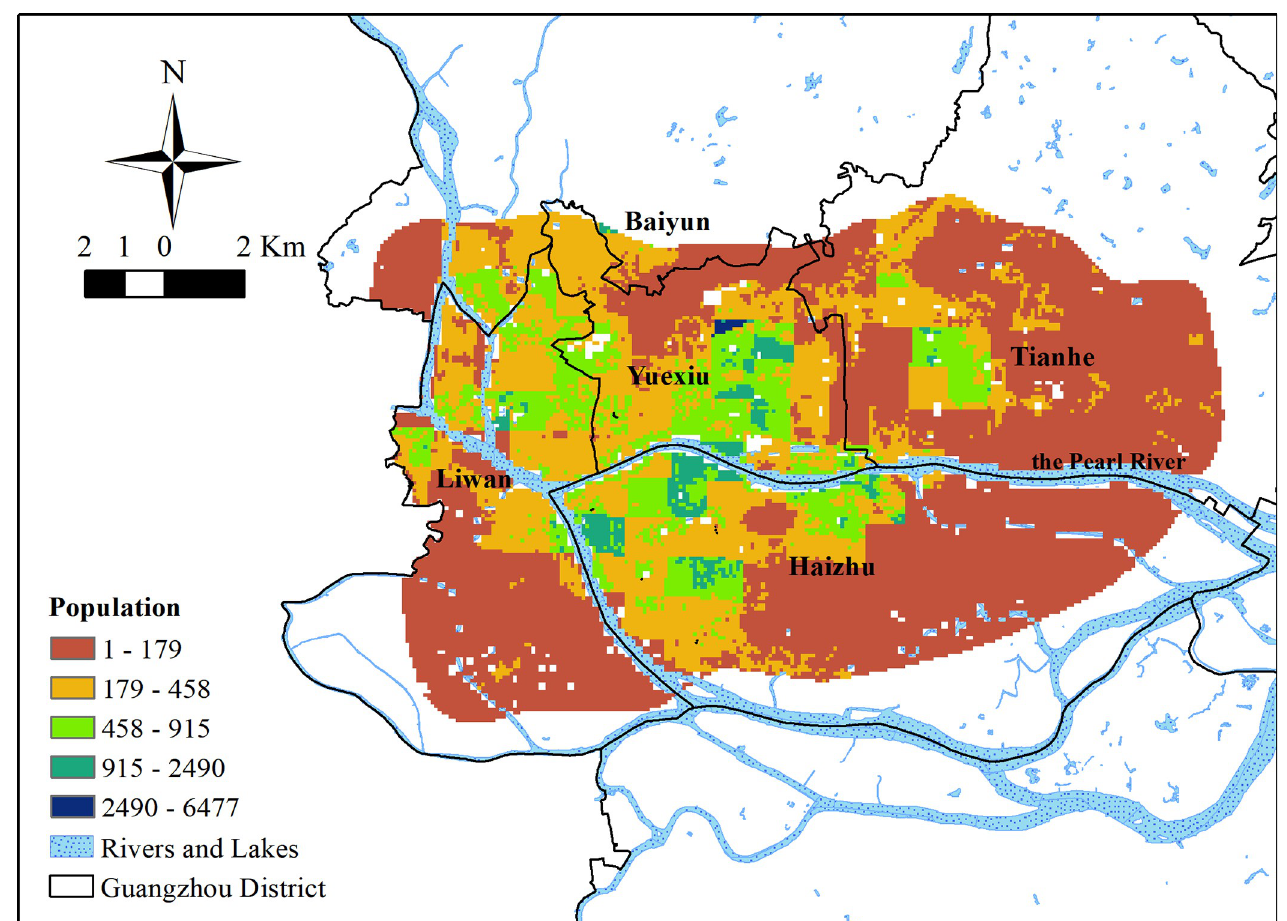
Fig 8. The population distribution in 100m � 100m metrics in the study